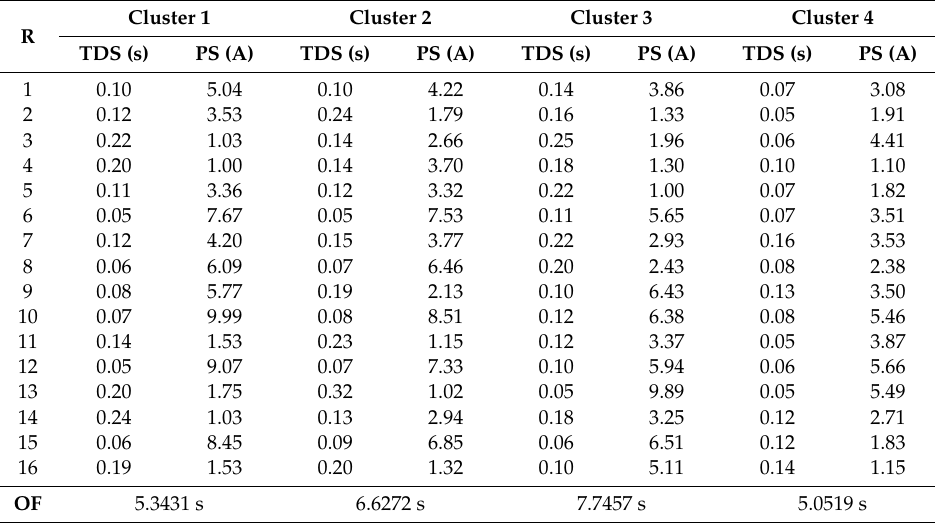
Table 15. Relay settings obtained for each cluster.